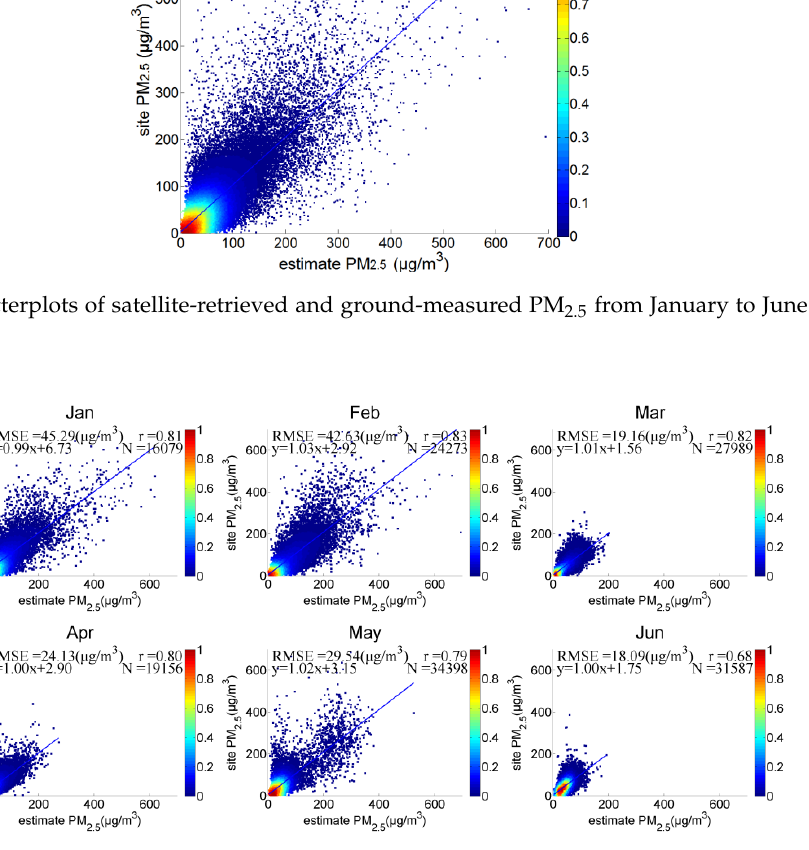
Figure 8. Monthly PM 2.5 of satellite-retrieved and ground-measured data in